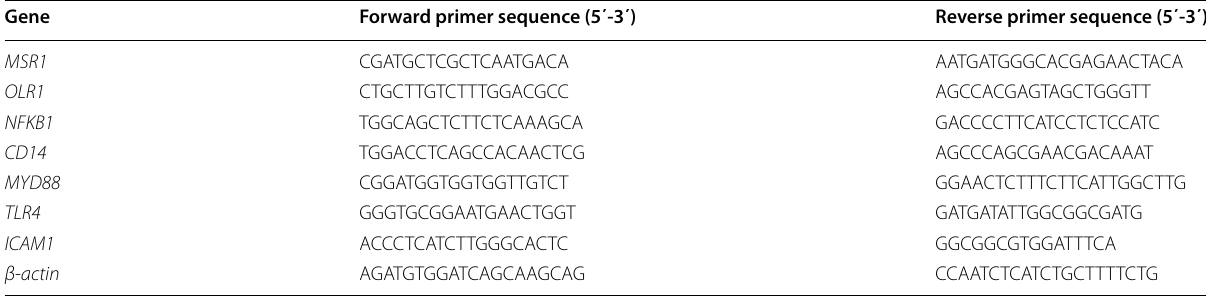
Table 1 Primers for Real-time